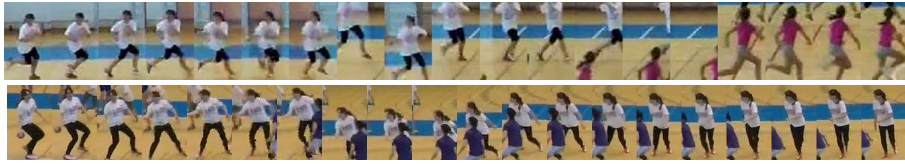
Figure 20. Examples of tracking problems.